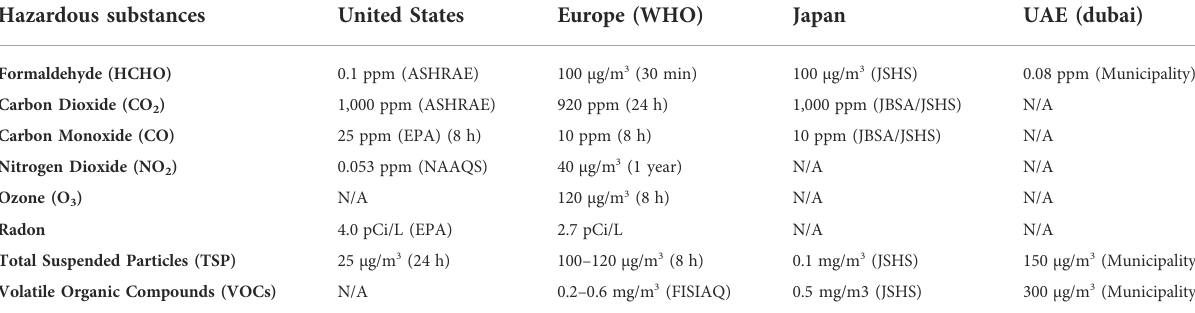
TABLE 3 Global standards for indoor air quality.